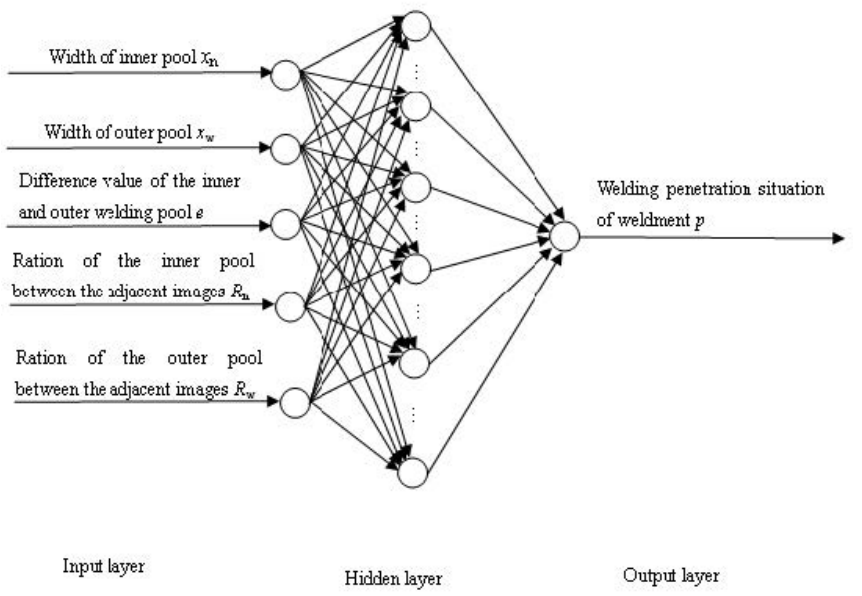
Fig. 11 Structure of the neural network for weld penetration prediction